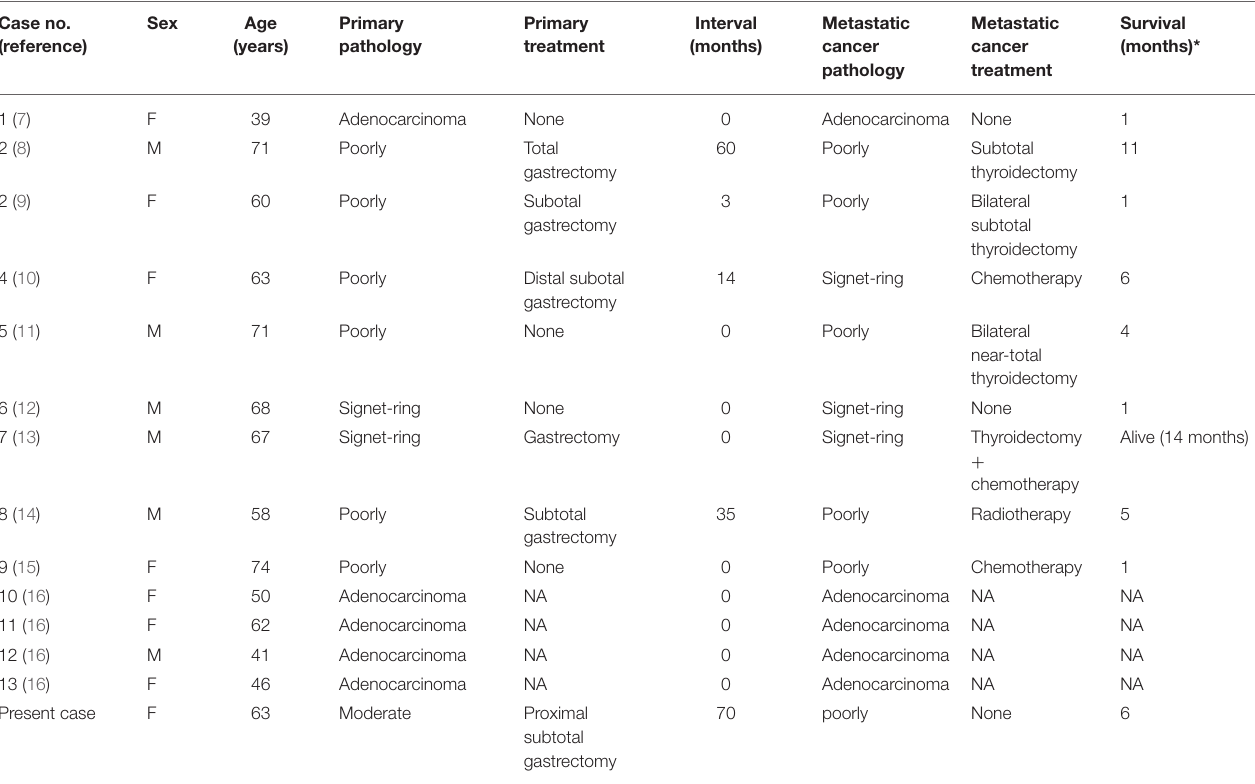
TABLE 1 | Clinical data of patients with metastatic thyroid tumors from gastric cancer. Case no. (reference)